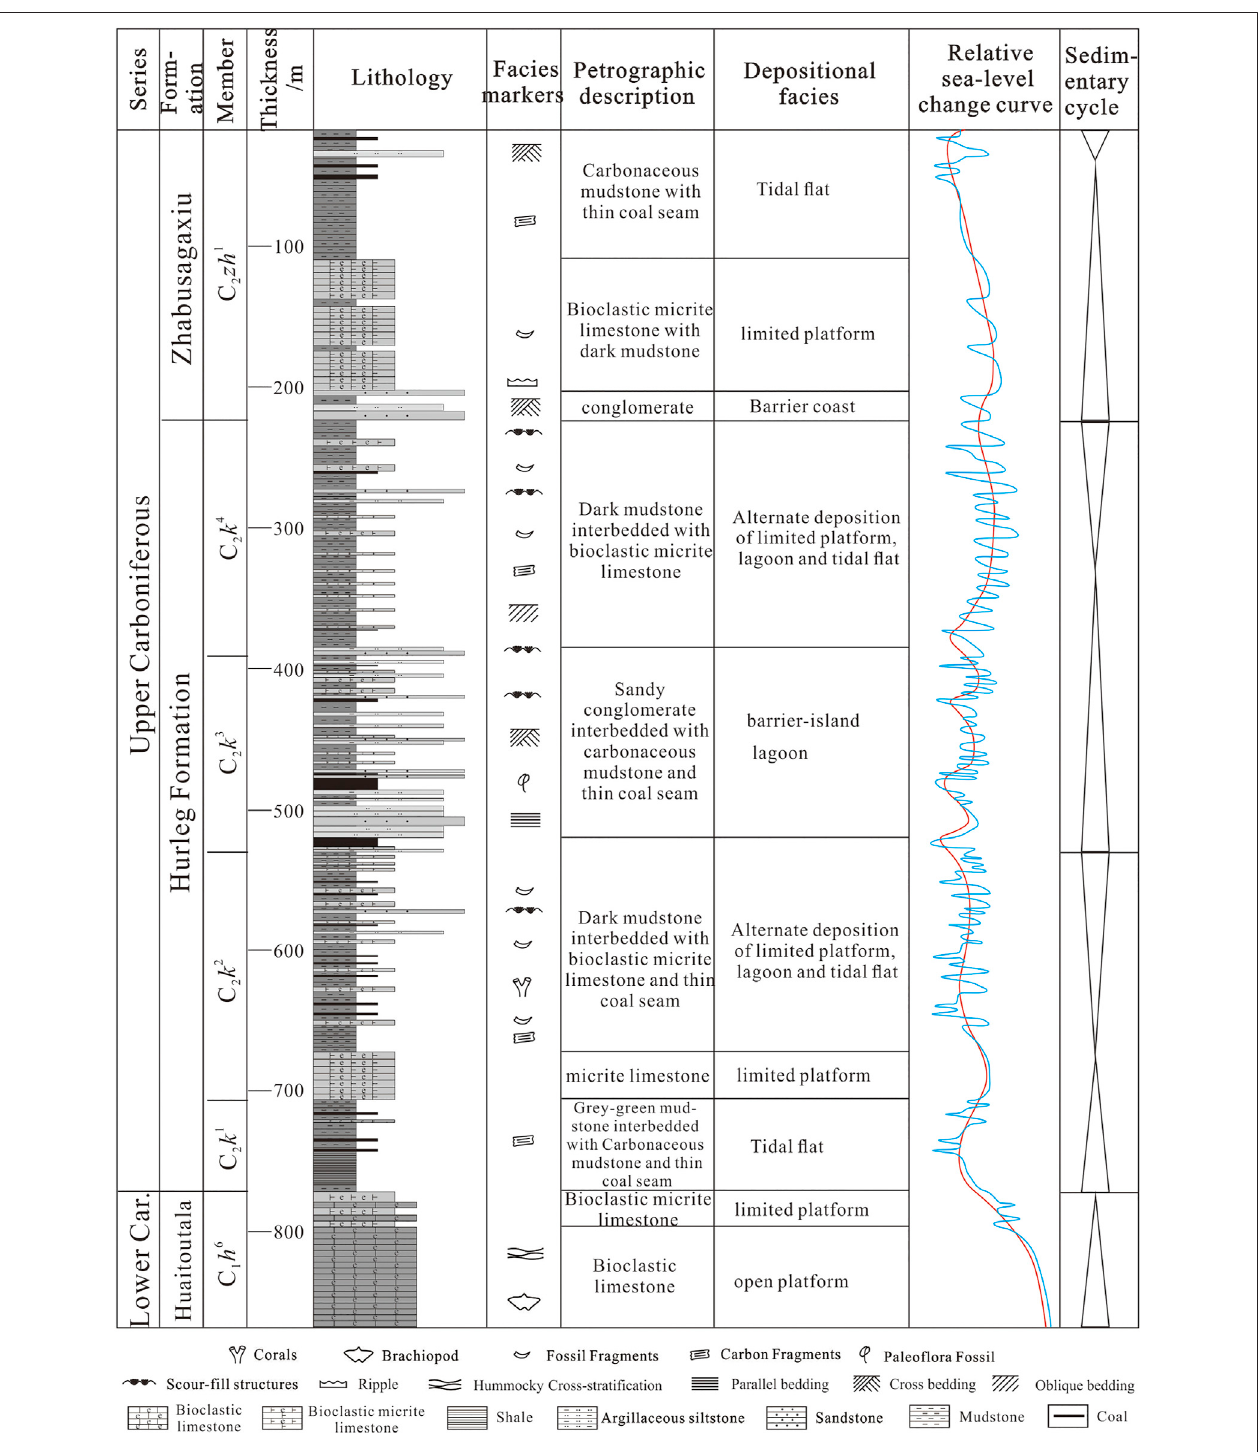
FIGURE2| ComprehensivestratigraphiccolumnoftheUpperCarboniferousKelukeFormationintheEasternQaidamBasin(modi fi edfromZhangetal.,2016and Qi et al., 2018).